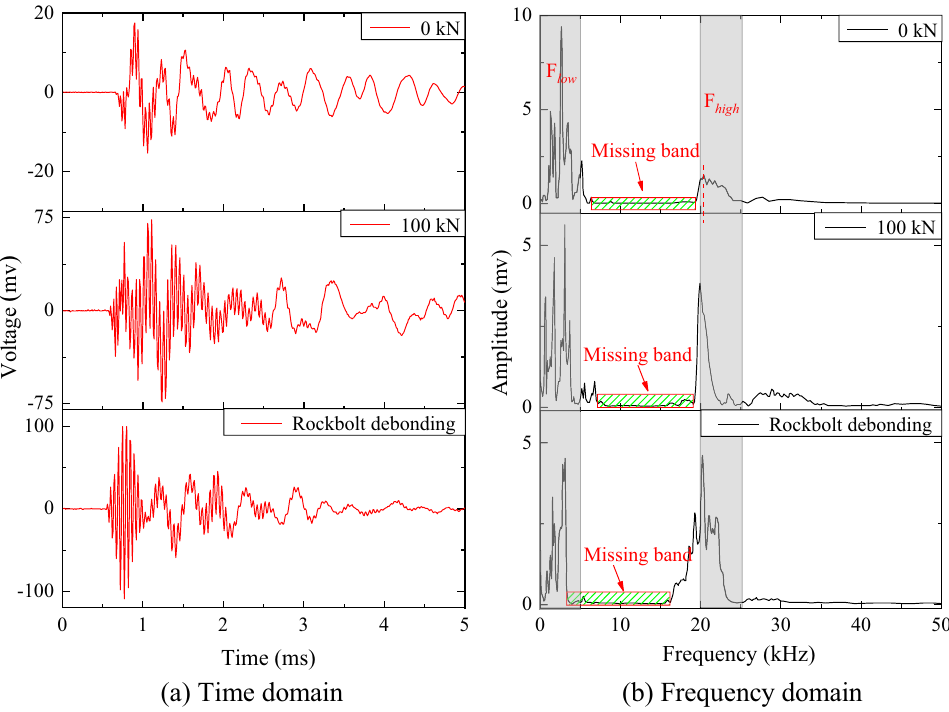
Fig. 6 Time domain and frequency domain characteristics in grouted rockbolt under different pull-out